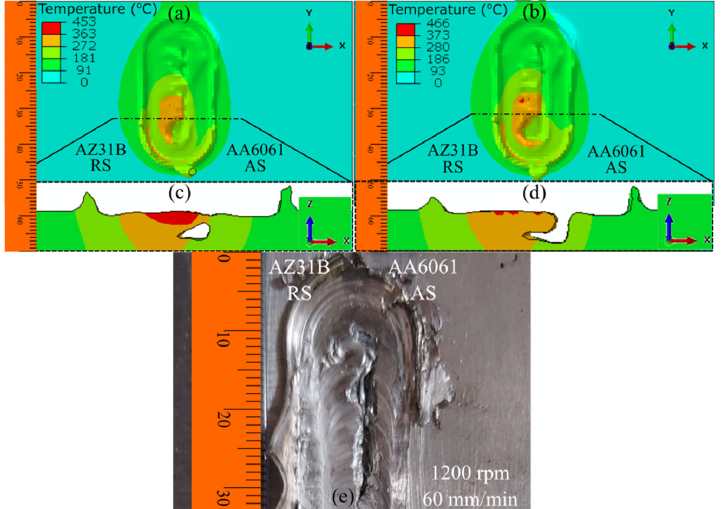
Figure 16. A comparative illustration of the progress of FSW at 1200 rpm and 60 mm/min with ( a ) the tool as shown in Figure 13a (without considering tool wear) and ( b ) the tool as shown in Figure 13c (with tool wear); ( c ) a cross-section view of the defect in Figure 16a and ( d ) a cross-sectional view of the defect in Figure 16b; and ( e ) the experiments on